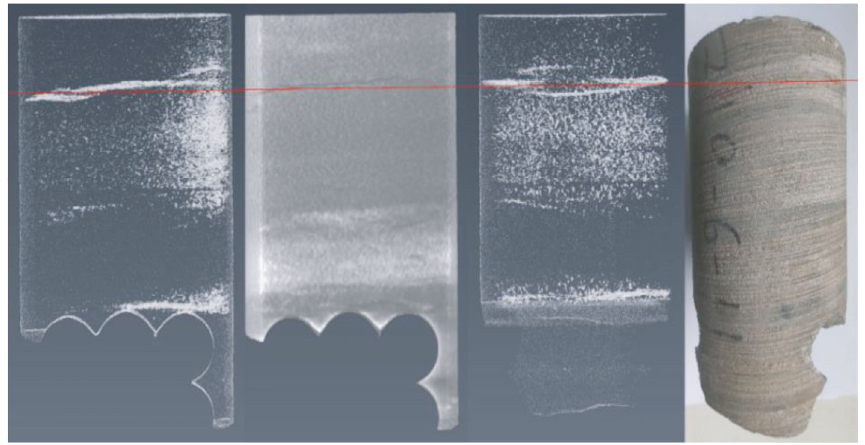
Figure 2: CT analysis of the middle-deep transition shale sample.